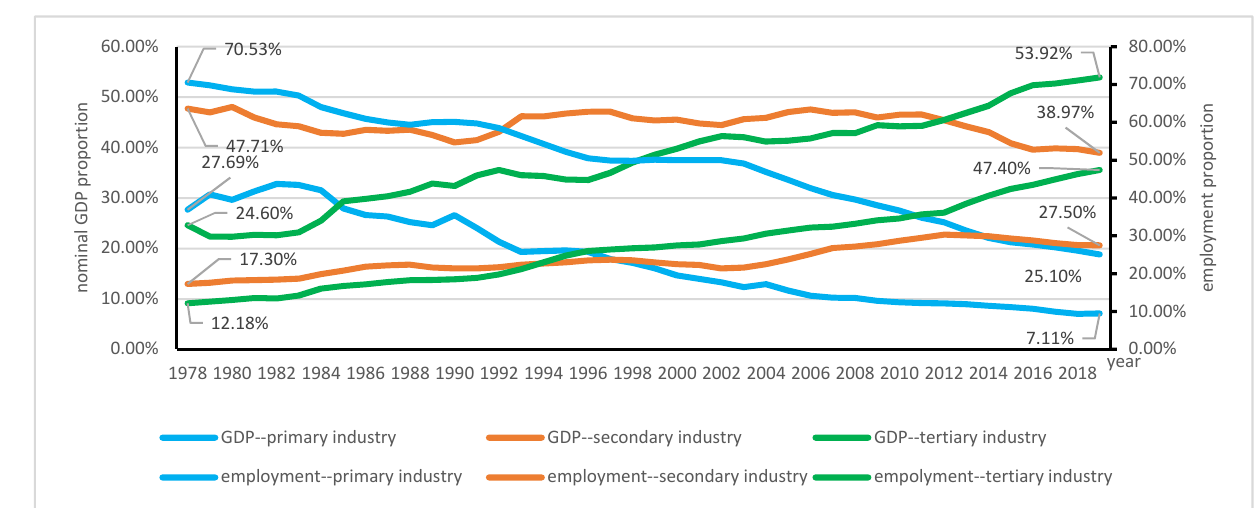
Figure 6. The composition of nominal GDP and employment of three industries in China (1978–2019).